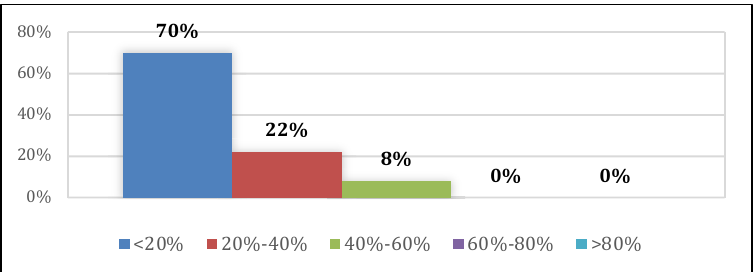
Fig. 4. Students’ opinion on their learning using PBL.